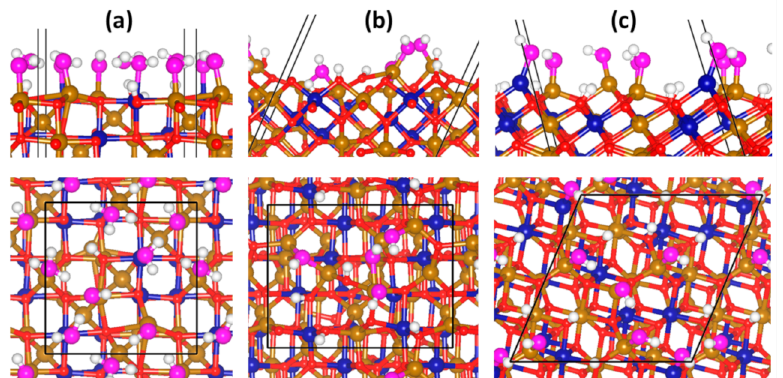
Figure 3. Optimised structures of H 2 O/OH covered ( a ) (001), ( b ) (110), and ( c ) (111) surfaces of Fe 2 CoO 4 in side (up) and top (down) views. H 2 O molecules enlarged for clarity (Fe = brown, Co = blue, O surf = red, O H2O = purple, H =